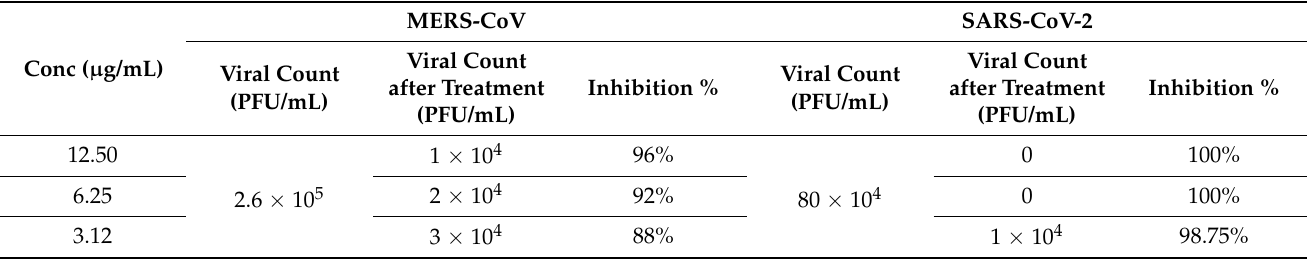
Table 2. Comparison between the antiviral activity of S. tomentosa (necklacepod) using plaque reduction assay against MERS-CoV isolate (NRCE-HKU270 (Accession Number: KJ477103.2)) and